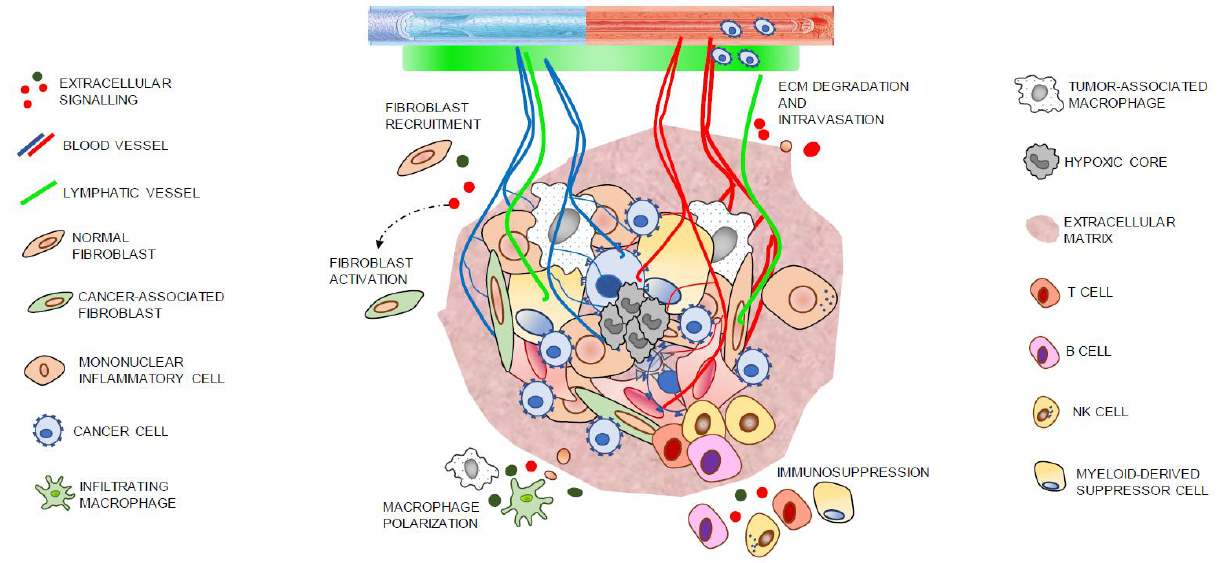
Figure 3. Schematic representation of the cellular components from a prostate tumor.